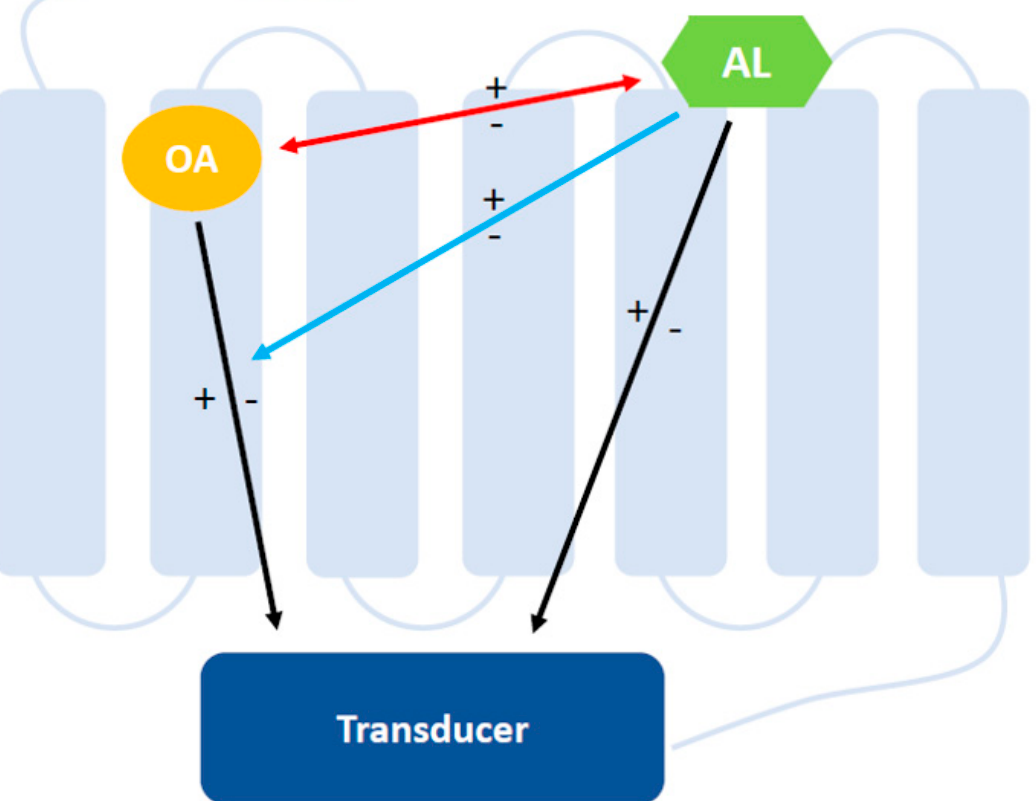
Figure 1. Allosteric modulation of class A G protein-coupled receptors (GPCRs). Orthosteric and allosteric binding sites are topographically distinct in the receptor protein. An allosteric ligand (AL) positively (+) or negatively (-) modulates the orthosteric agonist (OA) affinity (red arrow) and or efficacy (blue arrow) to the receptor. Moreover, allosteric modulators might have a direct agonist (+) or inverse agonist (-) effect on the receptor (black arrow) independent from the orthosteric ligand. The diagram was modified from Conn et al. (2009) [27].